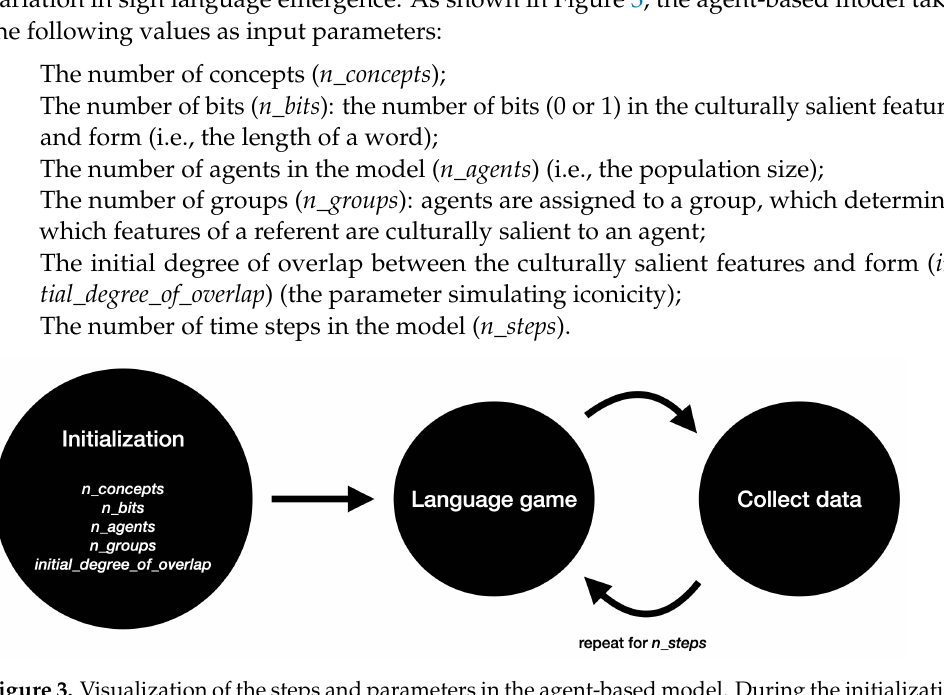
Figure 3. Visualization of the steps and parameters in the agent-based model. During the initialization phase, the number of groups ( n_groups ) determines how many subsets of the population have the same set of identical culturally salient features associated with concepts. Then, a number of agents are created ( n_agents ). Each agent is randomly assigned to a group, and their language representation is set given the following parameters: the number of concepts ( n_concepts ), the number of bits ( n_bits ) and the initial degree of overlap between the culturally salient features and form ( initial_degree_of_overlap ). At each time step, all agents initiate a language game (i.e., they take a turn as the sender). At the end of each time step, data on the mean degree of iconicity and the mean lexical variability are calculated. The model continues for a number of steps ( n_steps